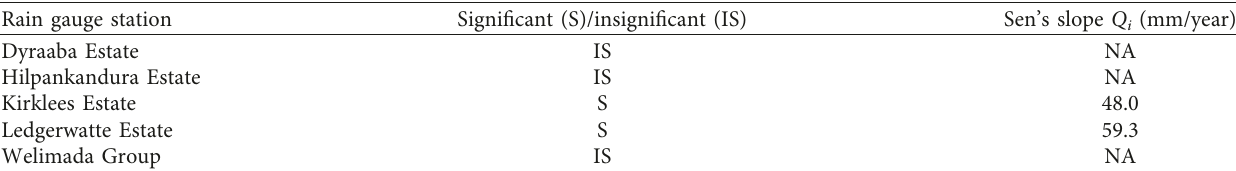
Table 1: Results of trend analysis for annual rainfall.